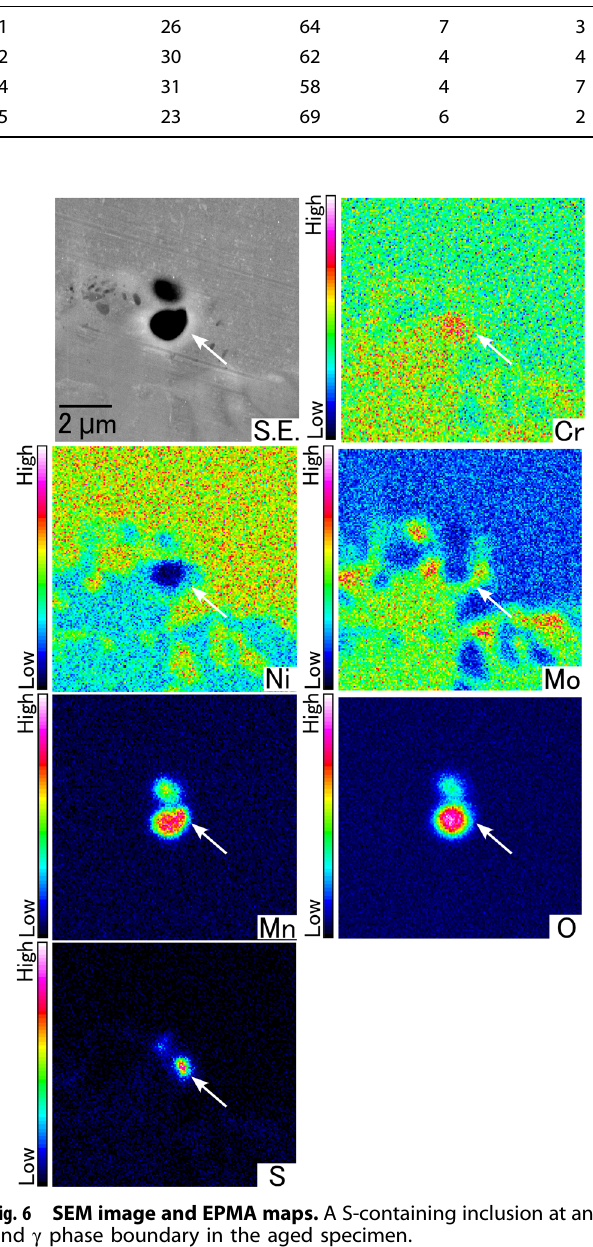
Fig. 6 SEM image and EPMA maps. A S-containing inclusion at an α and γ phase boundary in the aged